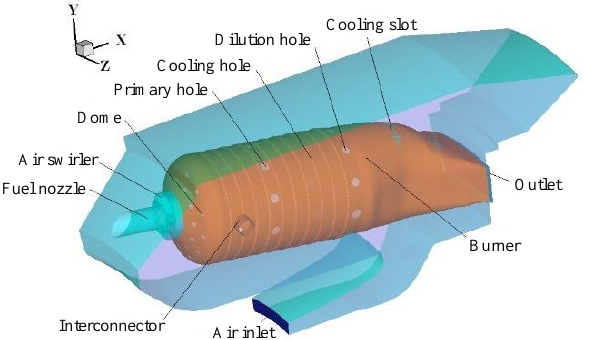
Figure 2. Can-annular combustor of a gas turbine.